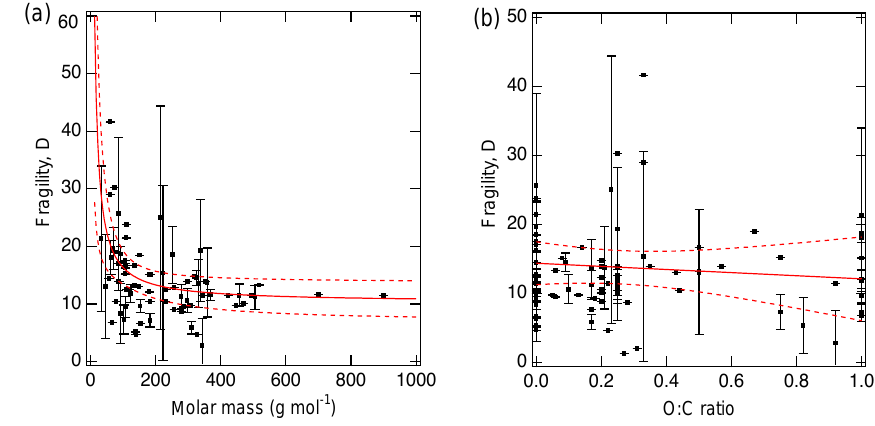
Figure 3. Fragility parameter of organic compounds ( D) plotted against (a) molar mass and (b) atomic O:C ratio. Error bars are standard deviations. The solid red lines represent the fitted curves with fitted equations for (a) D = 602 . 6 /M + 10.3 and (b) D = 14.4–2.3 (O:C). Dashed red lines indicate the 95% confidence